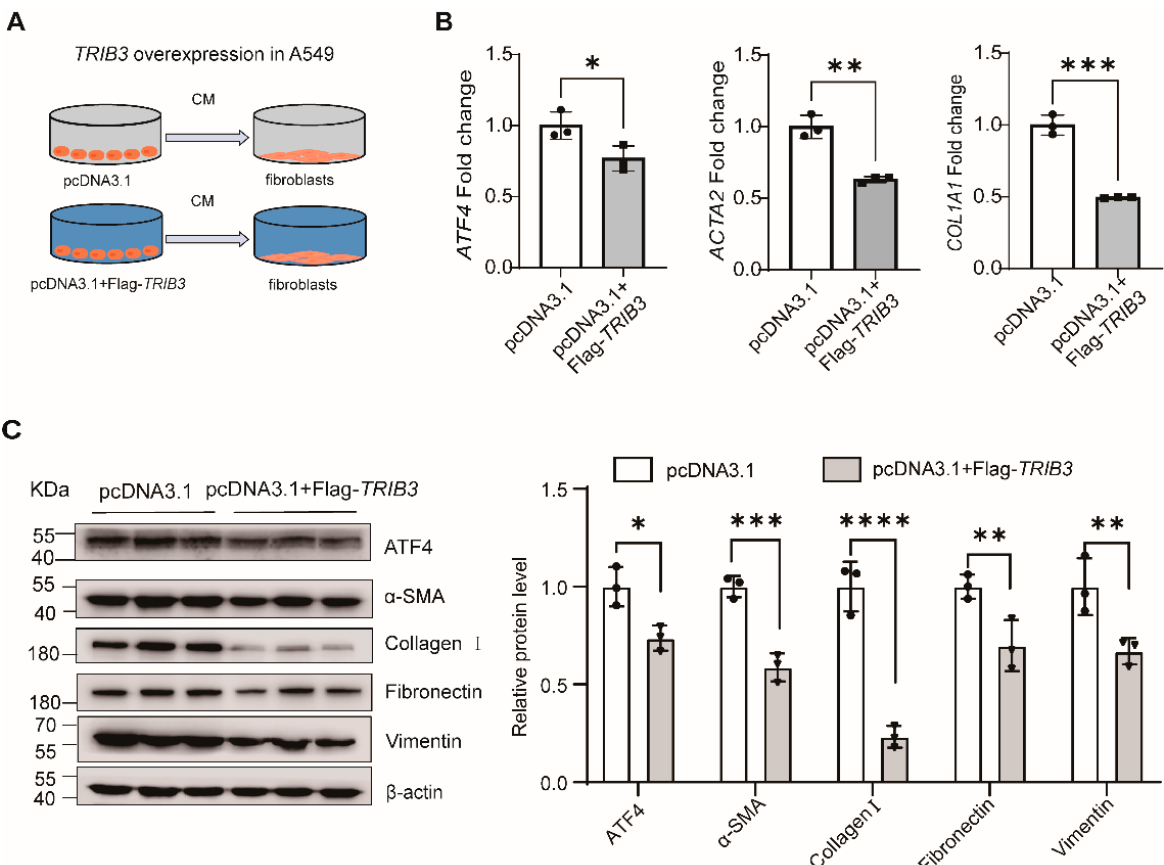
Figure 7. TRIB3 attenuates lung fibrosis by negative regulation of ATF4 . ( A ) Schematic of transfection of A549 cells before CM collection and transfer. CM from pcDNA3.1 or pcDNA3.1+Flag- TRIB3 - transfected cells was collected 72 h after transfection and transferred to human lung fibroblast (MRC5) for an additional 72 h. ( B ) qPCR analysis showing that CM from pcDNA3.1+ Flag- TRIB3 -transfected cells reduced the mRNA level of ATF4 and profibrotic genes in MRC5 cells. The results were analyzed by the unpaired Student’s t -test for comparisons between two groups with normal distribution. Data are presented as mean ± SD. * p < 0.05, ** p < 0.01 and *** p < 0.001. ( C ) Western blot analysis showing CM from pcDNA3.1+ Flag- TRIB3 -transfected cells reduced the expression of ATF4, α -SMA, Collagen I, Fibronectin, and vimentin. Significant differences between groups were evaluated by two-way ANOVA with Š í d á k’s multiple comparisons test for pairwise comparisons. * p < 0.05, *** p < 0.001 and **** p < 0.0001.